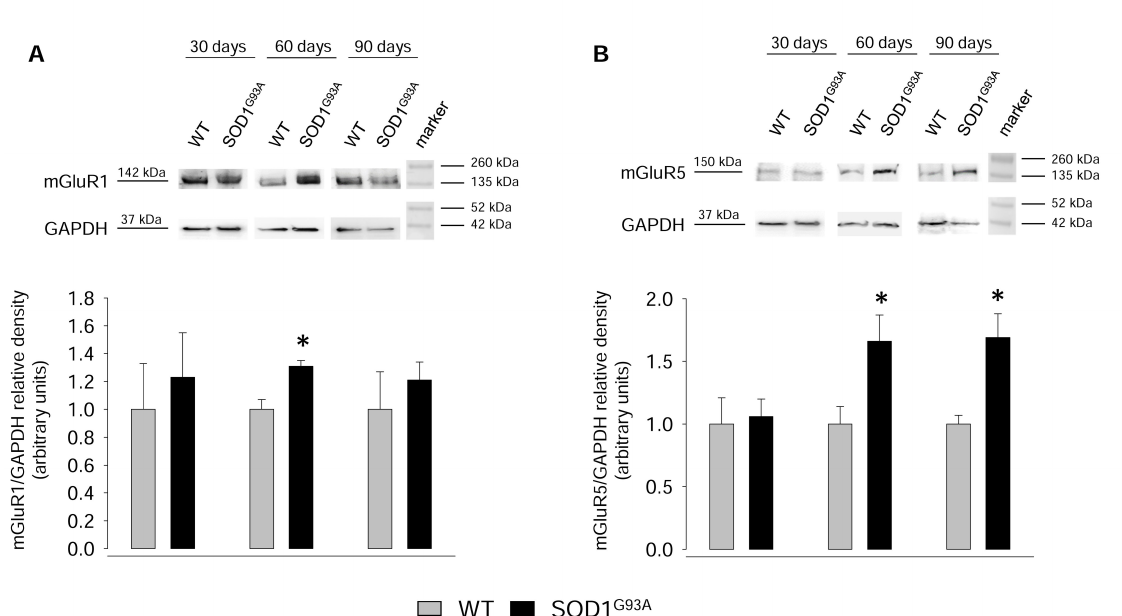
Figure 5. mGluR1 and mGluR5 expression in spinal cord total tissue from WT and SOD1 G93A mice. SOD1 G93A mice were sacrificed at postnatal day 30, 60, and 90. Age-matched WT mice were used as controls. ( A ) mGluR1 and ( B ) mGluR5 expression were measured by SDS 4–20% PAGE and WB onto nitrocellulose membranes, using 20 µ g of detergent soluble protein extracts from the homogenate of the whole spinal cord. Mouse monoclonal antibody anti-mGluR1, rabbit monoclonal antibody anti-mGluR5, and mouse monoclonal antibody anti-glyceraldehyde 3-phosphate dehydrogenase (GAPDH) were used. mGluR1 and mGluR5 expression levels were normalized for GAPDH in the same membrane. Representative immunoreactive bands and quantization (bar plots) are shown. mGluR1 and mGluR5 levels are expressed as the relative density of SOD1 G93A with respect to WT mouse bands, which is referred to as 1.00. Bars report mean ± SEM of five independent experiments (five WT and five SOD1 G93A mice) run in triplicate (three experimental replicates) are presented. No significant di ff erences were detected in 30-day-old mice, while significant di ff erences were found in 60- and 90-day-old mice. * p < 0.05 vs. WT mice (two-tailed student’s t